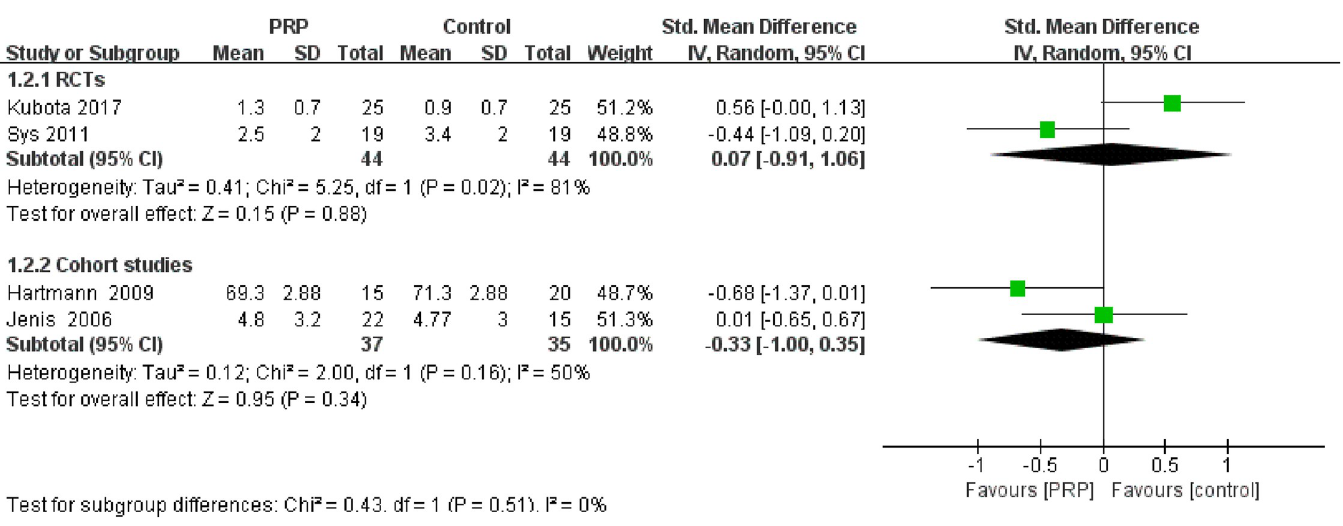
Fig 3. Forest plot of the VAS in the included